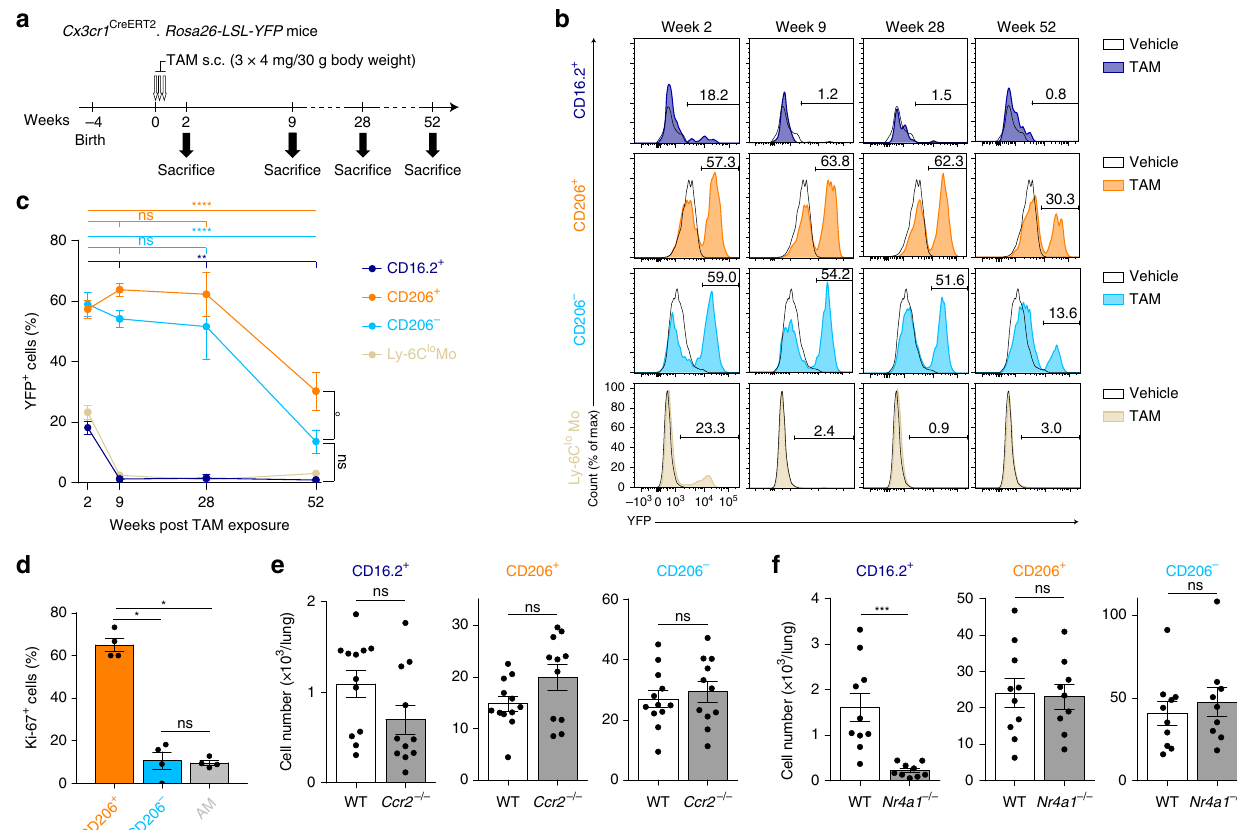
Fig. 3 Maintenance of lung tissue CD64 + mononuclear phagocytes in adult C57BL/6 mice. a Experimental outline for panels ( b , c ). Brie fl y, at 4 weeks of age, Cx3cr1 CreERT2 .Rosa26-LSL-YFP mice were treated with TAM s.c. 3 times, 48h apart. Mice were analyzed for YFP expression 2, 9, 28, and 52 weeks later. b Representative histograms of YFP expression within the indicated populations. Numbers indicate the percentage of YFP + cells, as quanti fi ed in ( c ). c Percentage of YFP + cells within the indicated populations, assessed by fl ow cytometry. d Percentages of Ki-67 + cells in the indicated populations. e , f Absolute numbers of the indicated cell populations in the lungs of e Ccr2 − / − or f Nr4a1 − / − and control WT mice. c – f Data show mean ± s.e.m., as well as individual mice in ( d – f ) ( c , n = 10; d , n = 4; e , f , n = 9 – 12) and are pooled from 2 to 3 independent experiments. P -values were calculated using ( c )